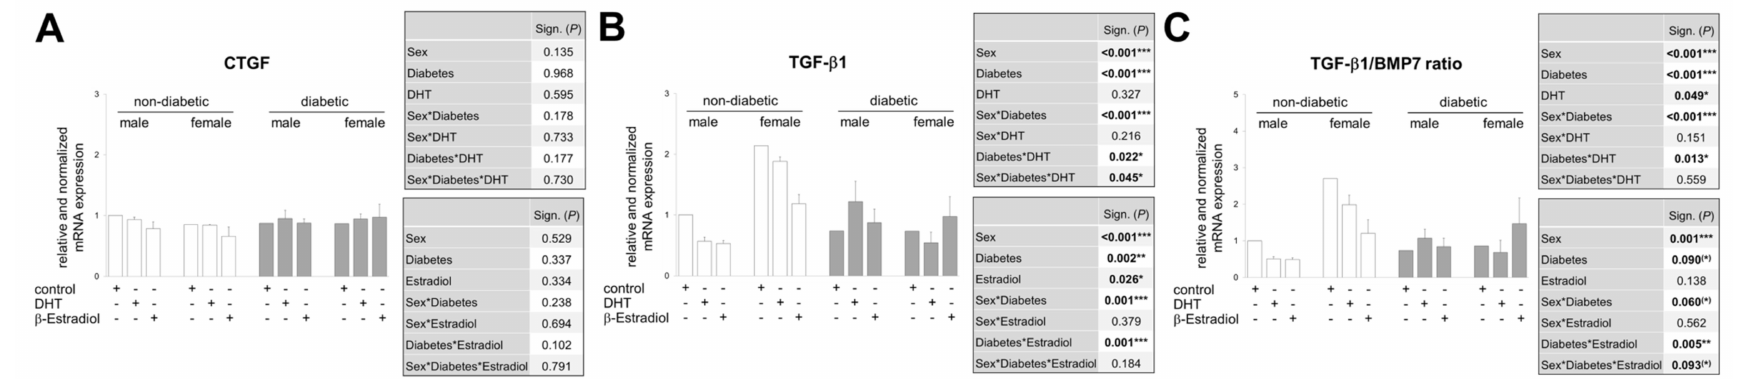
Figure 5. Real-time PCR analysis of mRNA expression in pieces of renal cortex treated in an ex vivo approach. ( A – C ) Treatment of cortical pieces from non-diabetic (3 males and 3 females) and diabetic (3 males and 3 females) mouse kidneys with control (DMSO) or sex hormones (DHT / β -estradiol) for 24 h. ( A ) CTGF mRNA analysis. ( B ) TGF- β 1 mRNA analysis. ( C ) Ratio from TGF- β 1 and BMP7 mRNA analysis. ( A – C ) The significances, shown in the upper table, were assessed using three-way ANOVA with sex (male or female), diabetes (non-diabetic or diabetic) and DHT as the three factors. The significances, shown in the lower table, were assessed using three-way ANOVA with sex (male or female), diabetes (non-diabetic or diabetic) and estradiol as the three factors. Sex, Diabetes, DHT, Estradiol: main e ff ect of sex / diabetes / DHT / Estradiol, respectively. Sex*Diabetes, Sex*DHT, Diabetes*DHT, Sex*Estradiol, Diabetes*Estradiol: interaction (determines whether the one main e ff ect depends on the level of the other main e ff ect). Sex*Diabetes*DHT, Sex*Diabetes*Estradiol: interaction (determines whether the third factor modifies the interaction between the other two factors). * P ≤ 0.05; ** P ≤ 0.01; *** P ≤